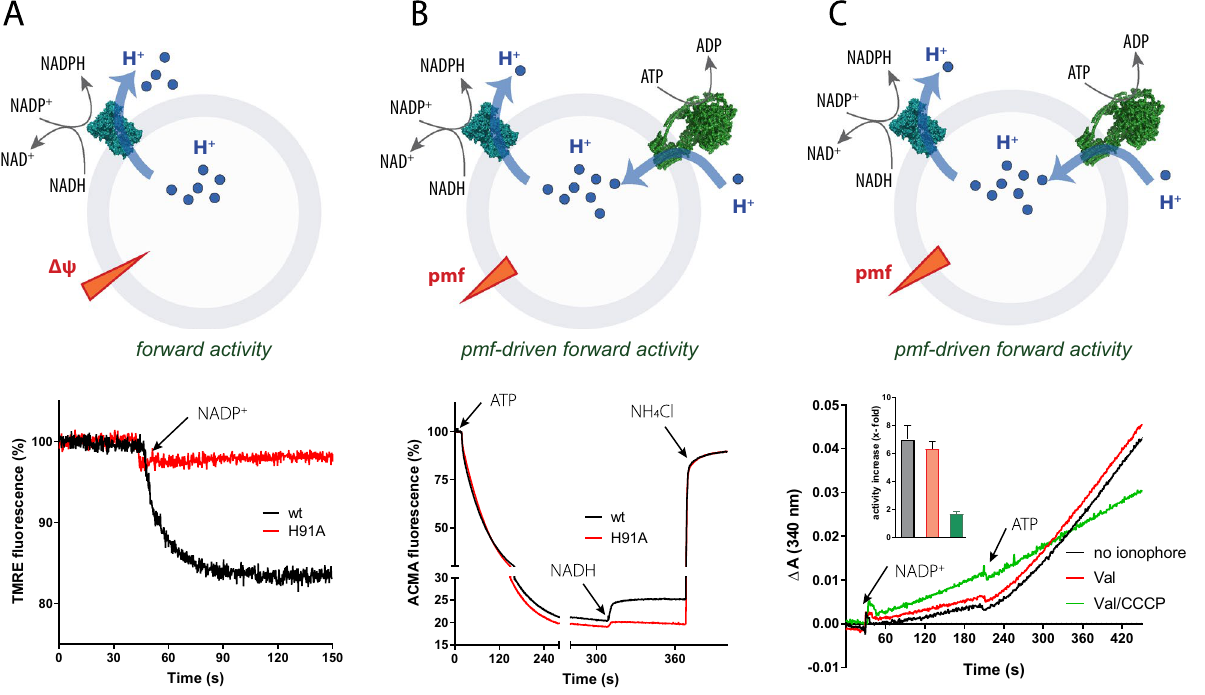
Figure 4. Forward activity of EcTH in reconstituted systems. ( A ) Proton pumping of reconstituted transhydrogenase during forward reaction was measured following TMRE fluorescence at λ ex/em 549/573 nm in 1.5 ml 50 mM HEPES pH 7.5, 100 mM KCl, supplied with 50 μl transhydrogenase proteoliposomes, 4 U/ ml glutathione reductase, 1 mM oxidized glutathione, 0.2 μM TMRE, and 200 μM NADH. Upon